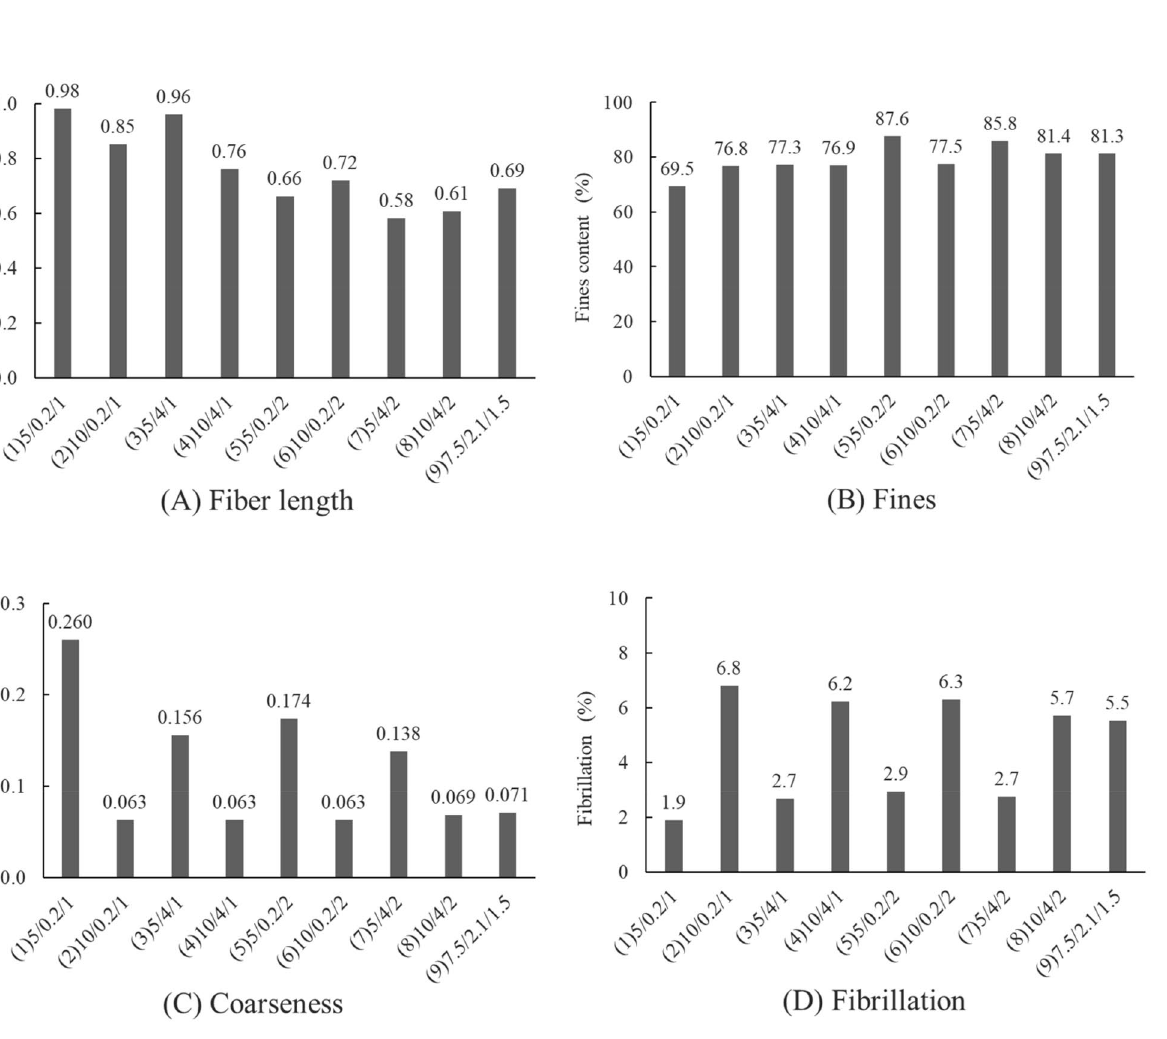
Figure 2. Effects of different treatment groups of rice straw semi-chemical mechanical pulp on fiber length ( A ), fines ( B ), coarseness ( C ) and degree of fibrillation ( D